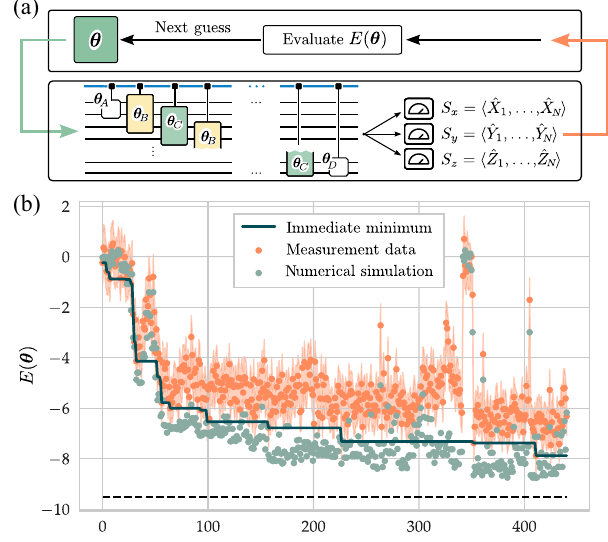
FIG. 4. (a) Sketch of the VQE protocol. (b) Energy E ð θ Þ of the prepared variational states j Ψ ð θ Þi for t − ¼ δ ¼ 0 during closed- loop optimization; errors are calculated considering shot noise and are shown as error bars. For each step, we show the immediate minimum that is reached thus far by a solid line; the energy of the exact ground state is shown as dashes. The numerical data are derived from simulations of the circuits for the respective parameters θ